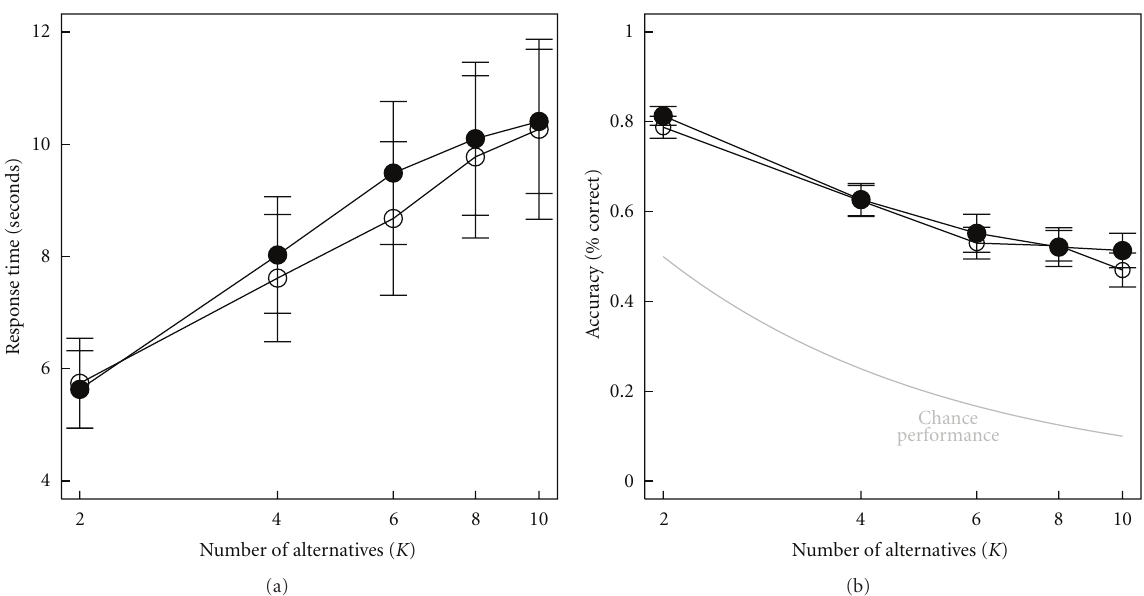
Figure 3: Mean response time (a) and decision accuracy (b) for the simple challenge and contextualised challenge (unfilled and filled circles, resp.).